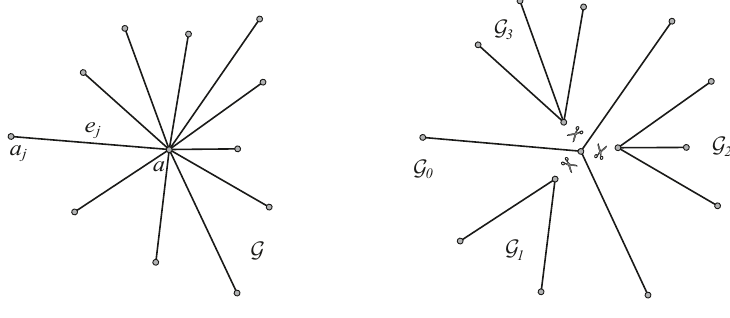
Fig. 1. The star graph G and the subgraphs G i